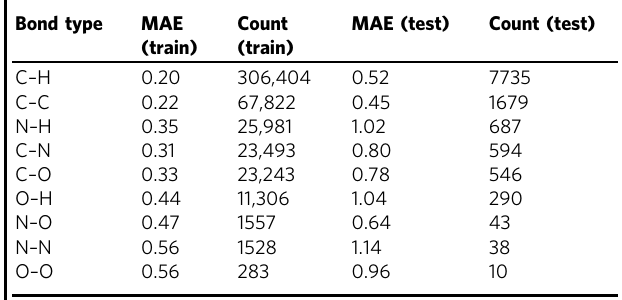
MAEs comparing DFT-calculated BDEs to ML predictions are shown along with the number of bonds for which the error was computed. MAEs are in kcalmol − 1